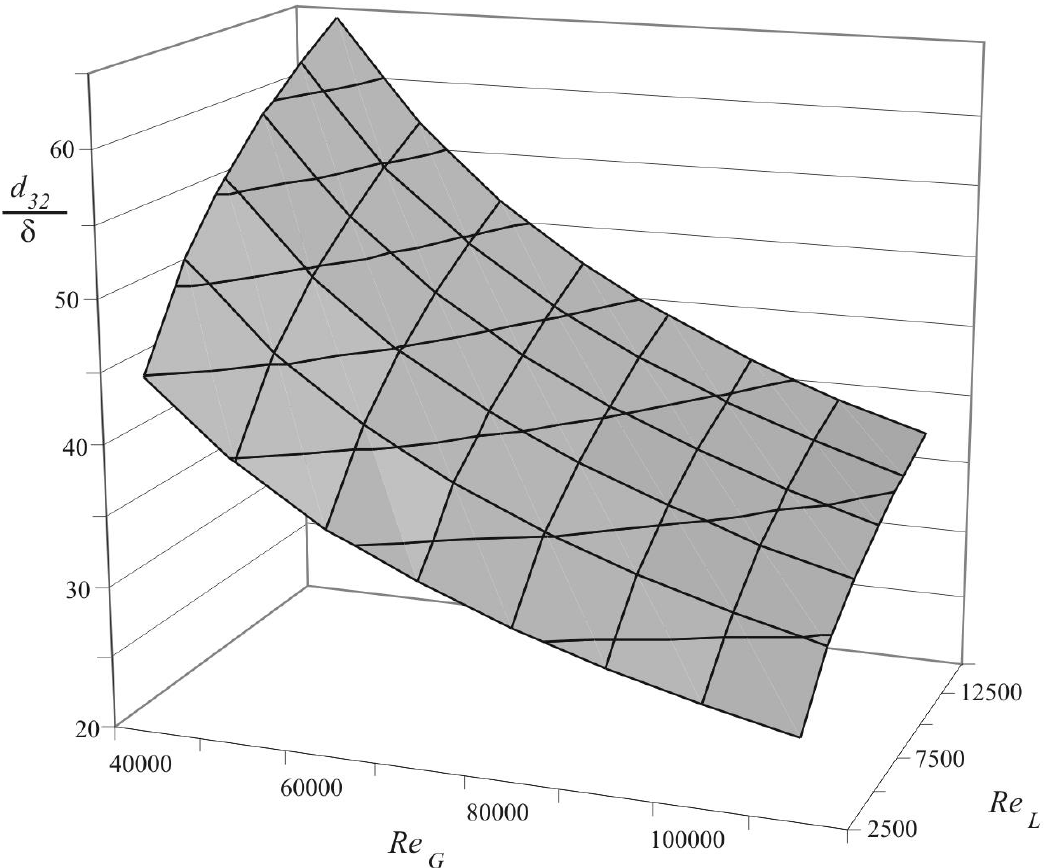
Figure 8. The relationship between reduced Sauter diameter d 32,r and Re G and Re L .